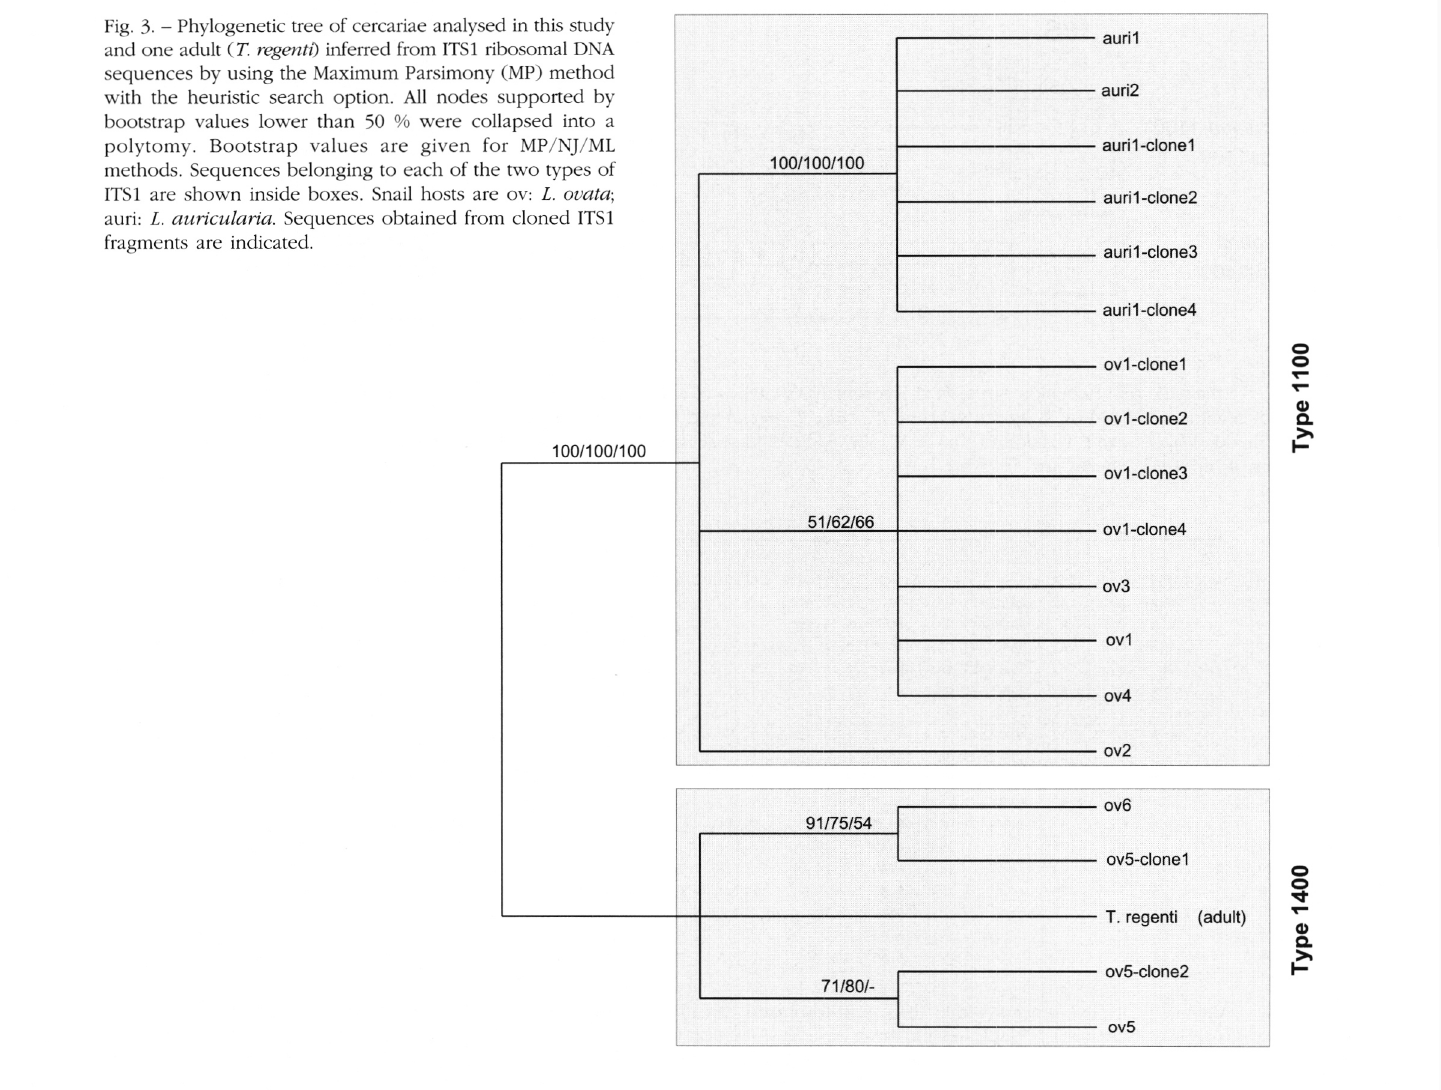
Fig. 3. - Phylogenetic tree of cercariae analysed in this study and one adult ( Tregenti) inferred from ITS1 ribosomal DNA sequences by using the Maximum Parsimony (MP) method with the heuristic search option. All nodes supported by bootstrap values lower than 50 % were collapsed into a polytomy. Bootstrap values are given for MP/NJ/ML methods. Sequences belonging to each of the two types of ITS1 are shown inside boxes. Snail hosts are ov: L. ovata; auri: L. auricularia. Sequences obtained from cloned ITS1 fragments are